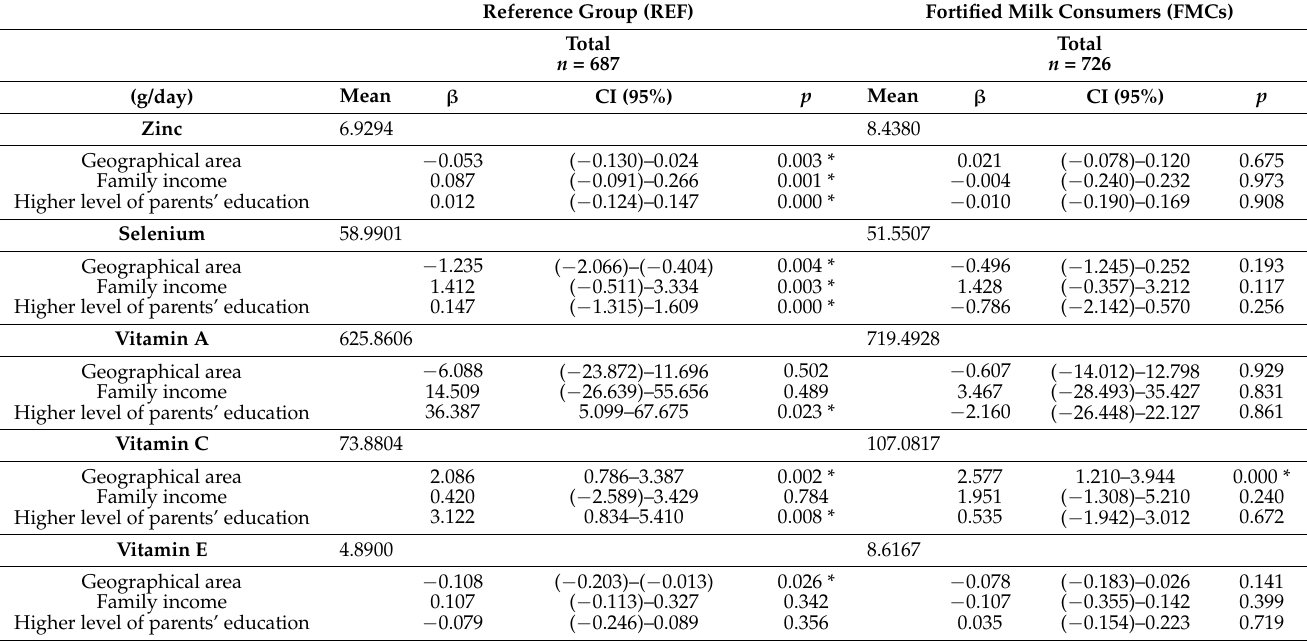
Table 4. Relationship between sociodemographic characteristics and total antioxidant minerals and vitamin intakes of the two